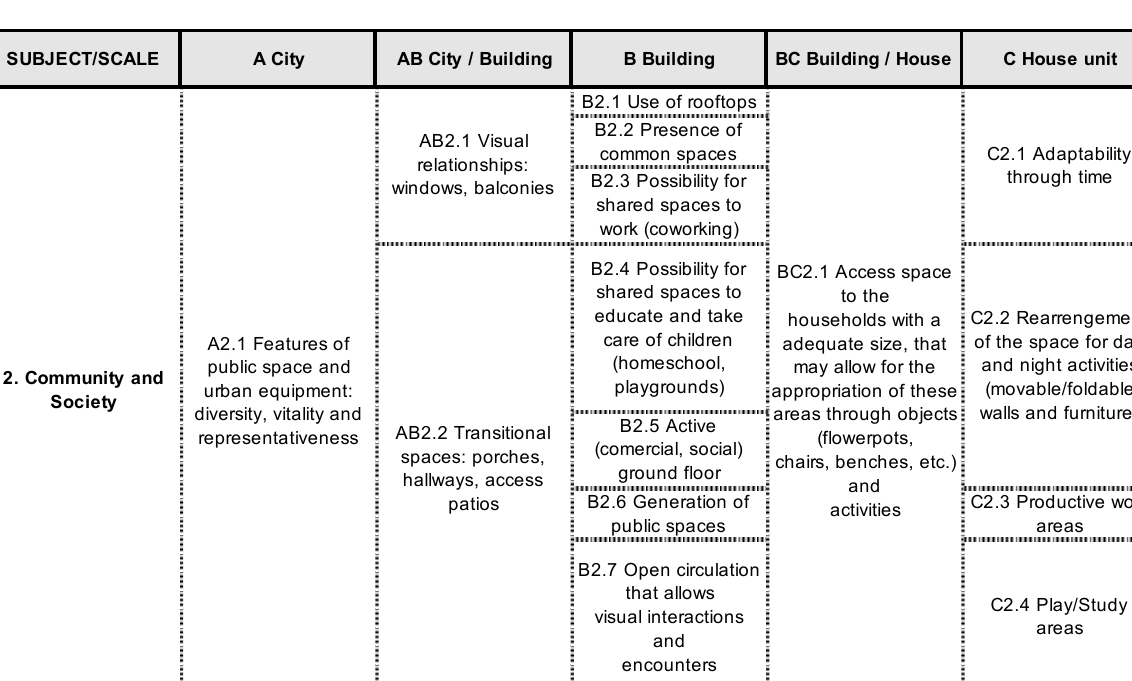
Figure 2. Community and Society Indicators. Source: Own elaboration. Category 3: The Gender and Inclusion indicators bring together all those parameters that have to do with inclusion and gender, from the security and accessibility of public space, the presence of facilities that allow the development of daily life in the vicinity of the home, to the presence in the building and in the home of spaces that favor the devel ‐ opment of care tasks, as shown in Figure 3.